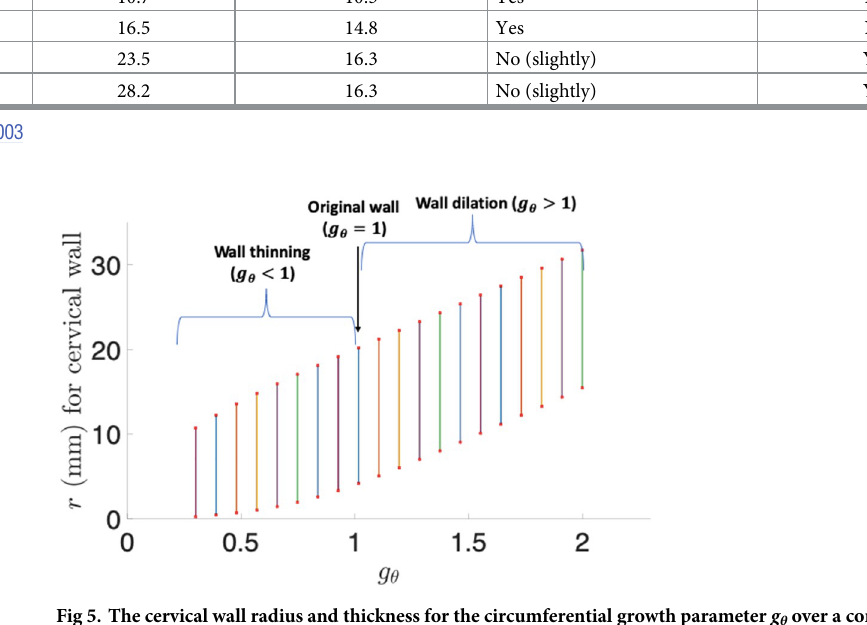
Table 4. Cervical wall thinning and dilation results for different axial growth parameters g g z r 1 r 4 Thickness